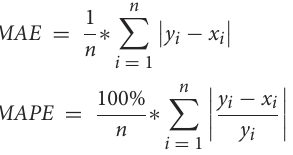
TABLE 1 Descriptive statistics and comparison between the CMJ-height measured by the Polar Vantage V2 sports watch and calculated via the flight time method from the force plate data.